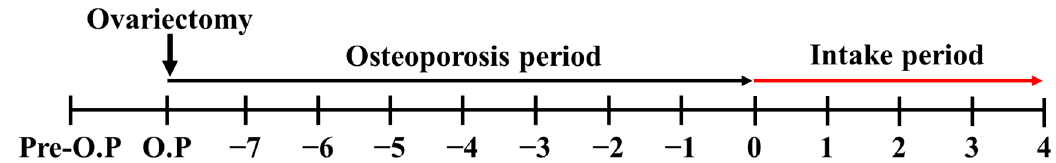
Figure 1. Experiment timeline (O.P: operation, Pre-O.P: pre-operation, 1 week before operation). After performing an ovariecomy in female Sprague Dawley (SD) rats, they were given regular food and water for 8 weeks and osteoporosis was induced. Then, phosphate-buffered saline (PBS) or heat-treated melon extract (ECO-A) was orally administered 3 times a day during the intake period.